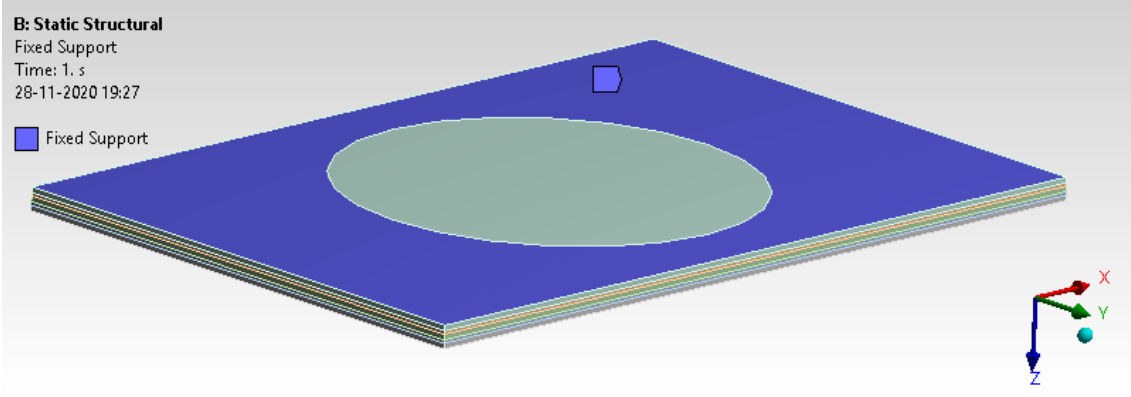
Figure 15. Mesh generation.